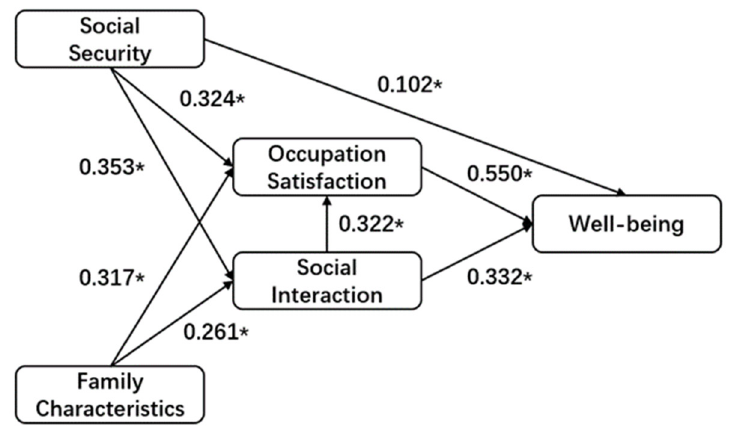
Figure 5. Modified SEM (* p < 0.05). Table 12. Overall Fitting Coefficient Table of Modified SEM. χ 2 /